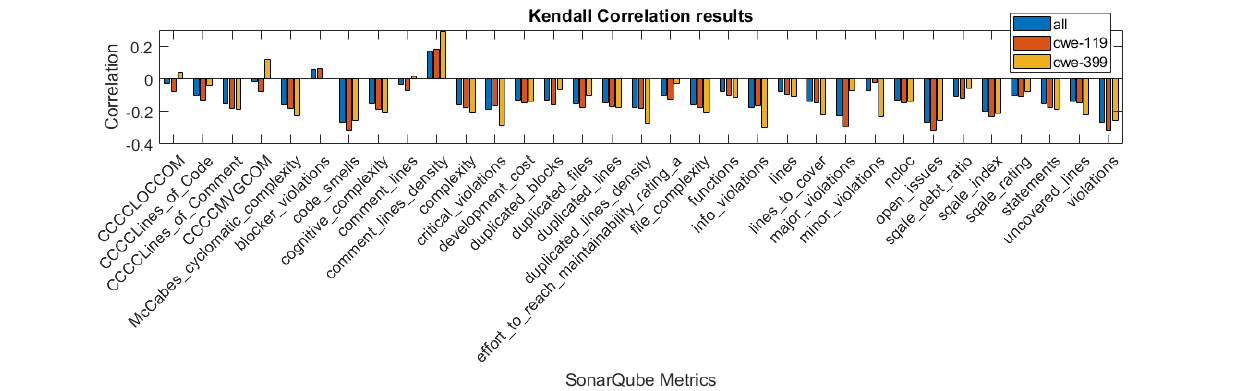
Figure 2. Spearman correlation values for the features obtained using different subsets of a dataset.